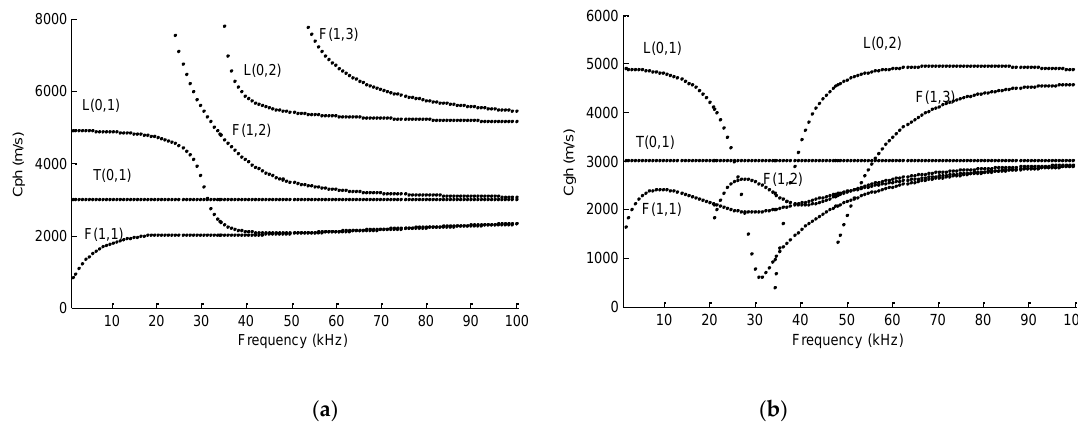
Figure 5. Dispersion curves of the referential hollow cylinder with the inner radius of 20 mm and the thickness of 10 mm: ( a ) Phase velocity dispersion curves; and ( b ) group velocity dispersion curves.